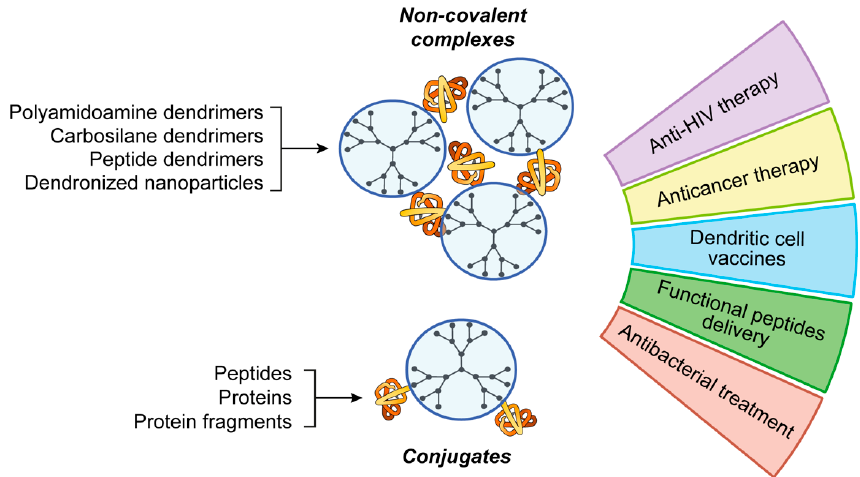
Figure 3. Applications of dendrimers for peptide and protein delivery.